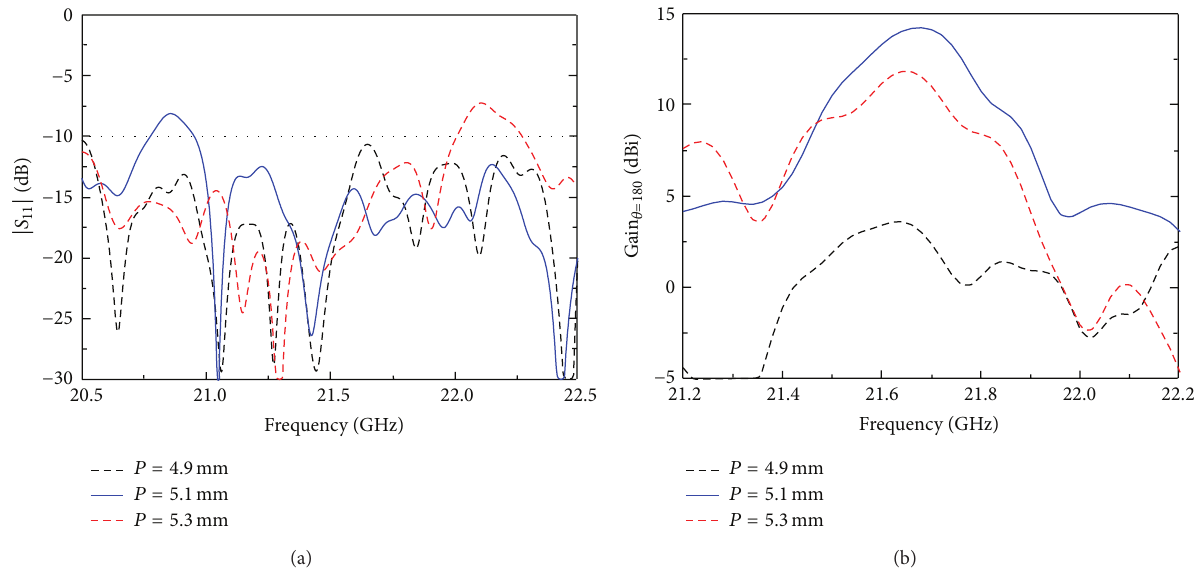
Figure 6: Effect of the hole periodicity, 𝑃 , on antenna characteristics with respect to (a) the reflection coefficient and (b) boresight